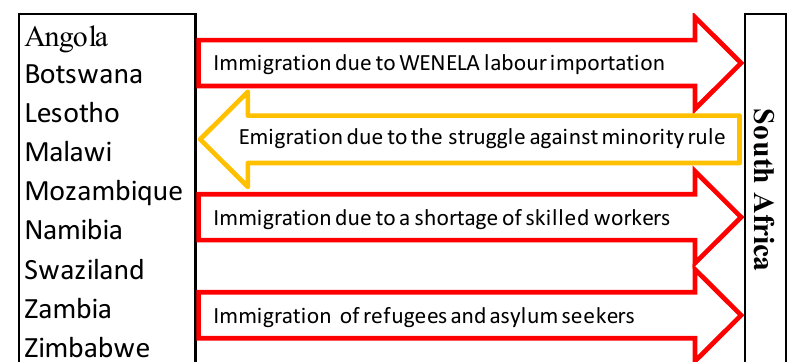
Figure 3: Immigration into South Africa from neighbouring countries and emigration out of South Africa into neighbouring